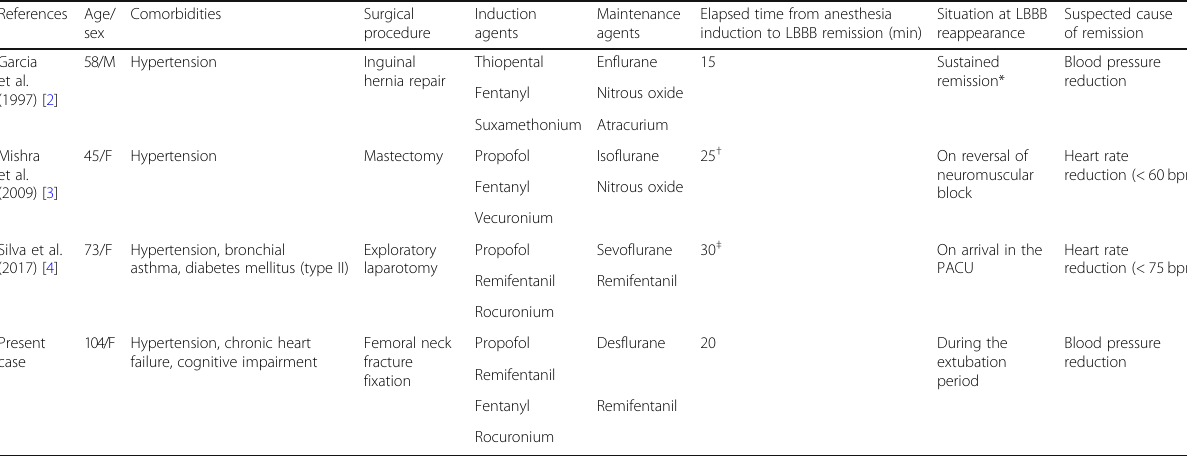
Table 1 Previously reported cases of transient remission of pre-existing left bundle branch block during general anesthesia References Age/